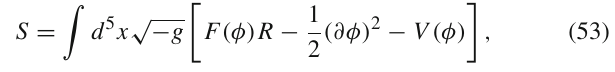
Eqs. (46) and (54). With the coordinate transformation